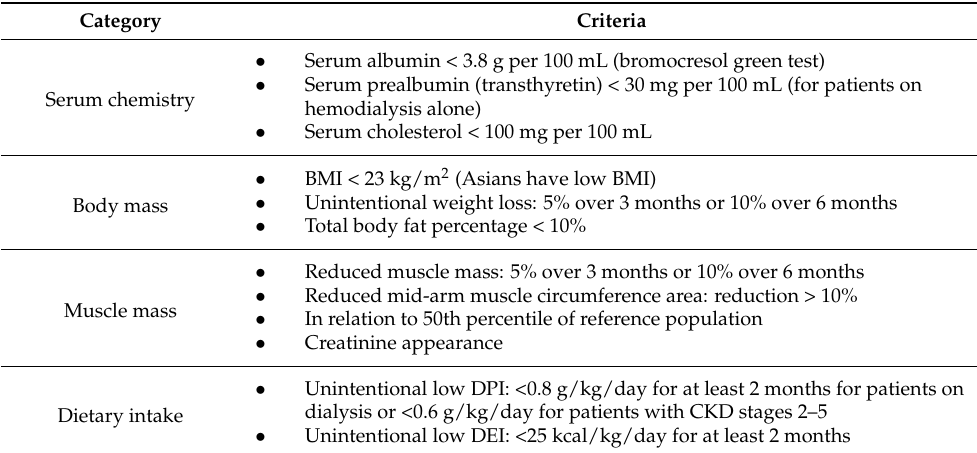
Table 3. Protein energy wasting (PEW) diagnostic